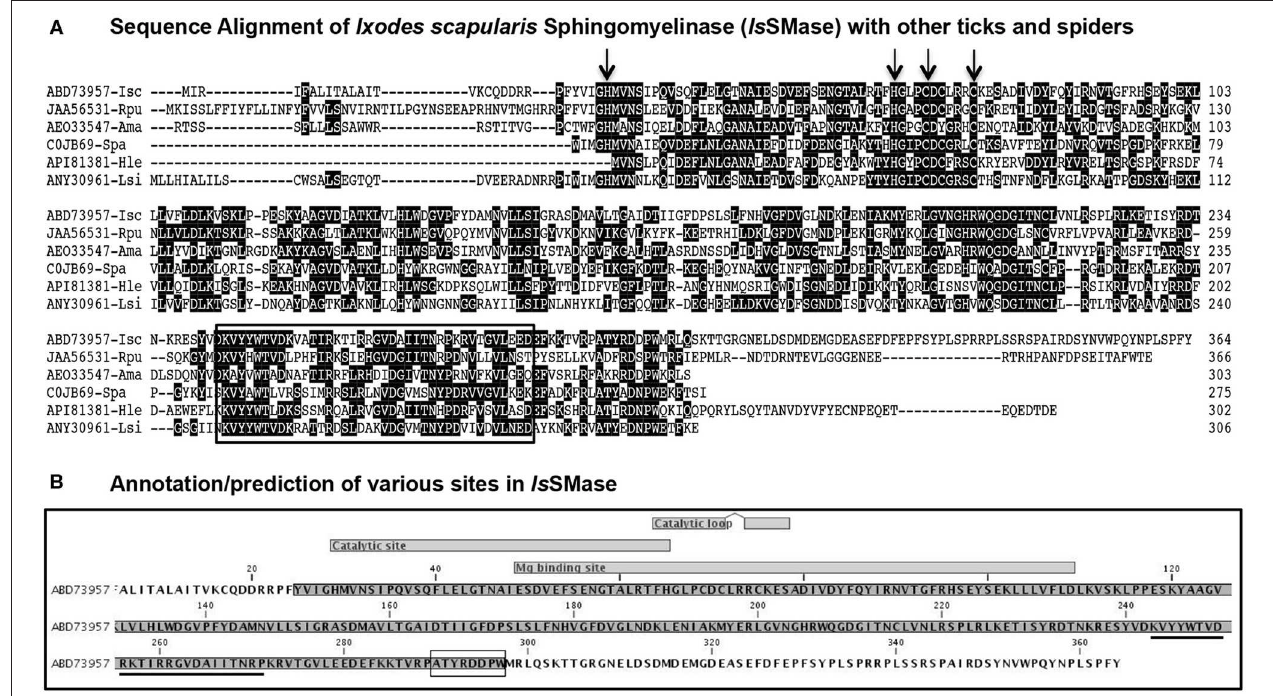
FIGURE 1 | Sequence alignments and prediction analysis of Is SMase with tick and spider orthologs. (A) The deduced I. scapularis ( Isc ) SMase ( Is SMase) amino acid sequence alignment (with other orthologs) using ClustalW program in DNASTAR Lasergene is shown. Matching residues are shaded in black color. GenBank accession numbers for R. pulchellus ( Rpu ) sphingomyelin phosphodiesterase, A. maculatum ( Ama ) hypothetical protein, S. patagonicus ( Spa ) sphingomyelinase D, H. lepturus ( Hle ) venom toxin, and L. similis ( Lsi ) loxtox protein sequences are shown. GenBank accession numbers for Isc , Rpu , and Ama are provided. Total length of the amino acid sequence is provided at the right end of each sequence. (B) Annotation/prediction analysis performed in CLC Genomics Workbench 20.0 for Is SMase protein sequence is shown. The catalytic site and magnesium binding sites and their overlap site are shown. The underlined sequence indicates